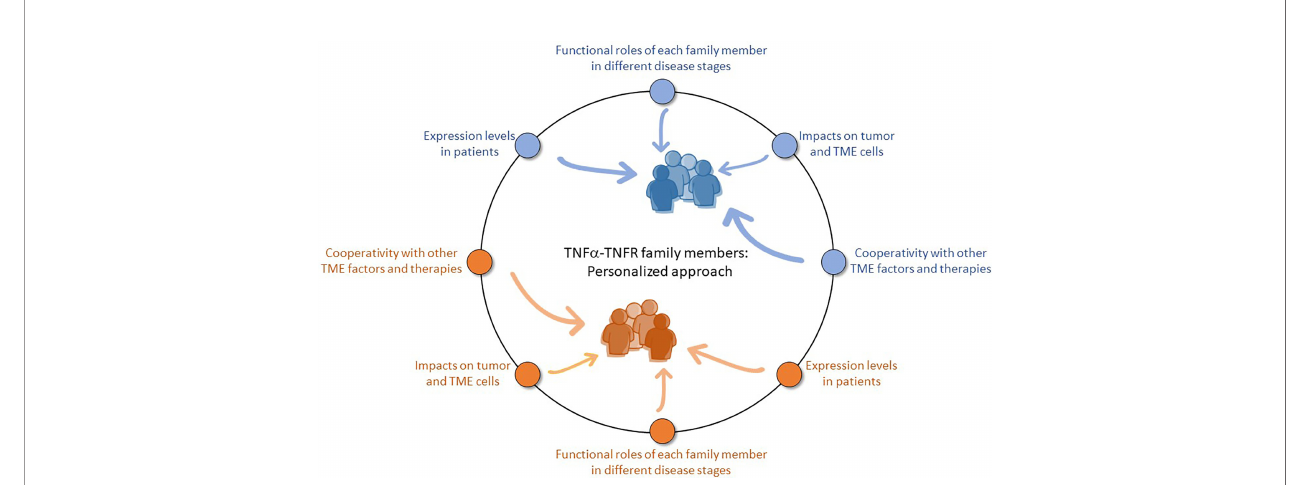
FIGURE 1 | Targeting members of the TNF a -TNFR family in cancer: The personalized road. The TNF a -TNFR network brings together complex interactions between the soluble and membrane forms of TNF a , as well as TNFR1 and TNFR2 with their diverse binding preferences to each of the TNF a forms, complex signaling cascades and soluble variants. This intricate system of ligands and receptors can lead to different consequences in various malignancies, raising the need to carefully identify speci fi c players in each and every disease type, and possibly also in patients who were diagnosed with the same type of cancer. Thus, a personalized approach should be designed in order to establish the most appropriate and ef fi cient therapeutic mode in cancer, vis-à-vis the use of modi fi ers of TNF a and its receptors. For example, the properties of one malignant disease ( “ Blue patients ” in the Figure) in terms of TNF a -TNFR family members may considerably differ from the characteristics of another cancer type ( “ Orange patients ” ). To precisely identify who can bene fi t from treatments directed to any of the family members, it is necessary to determine the expression patterns of each partner in each patient; then, based on analyses of each malignancy and its subtypes, it is necessary to determine their roles in different disease stages, their impacts on different cell types in the tumor (cancer cells, endothelial cells, leukocytes, stromal cells), as well as their interactions with other TME factors and potential ef fi cacy when combined with other cancer therapies. The information obtained by research of the different aspects and elements stands in the basis of a personalized approach that will target members of the TNF a -TNFR family or exploit them (e.g., by increasing the proportions/activities of bene fi cial TNFR2+ CD8+ TILs) that would reach an outmost ef fi cacy in cancer